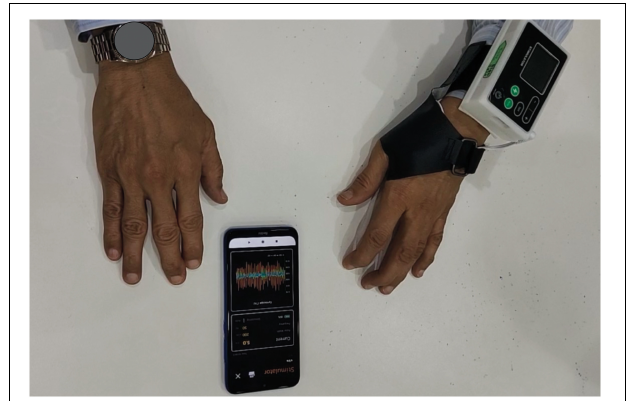
FIGURE 1 | The Parkinson’s glove. The Parkinson’s glove is a specially designed adjustable glove, which incorporates a tremor detection module and an electrical muscle stimulation module to detect and suppress resting hand tremors. The control panel was developed using an Android application on a mobile phone connected via Bluetooth to the Parkinson’s